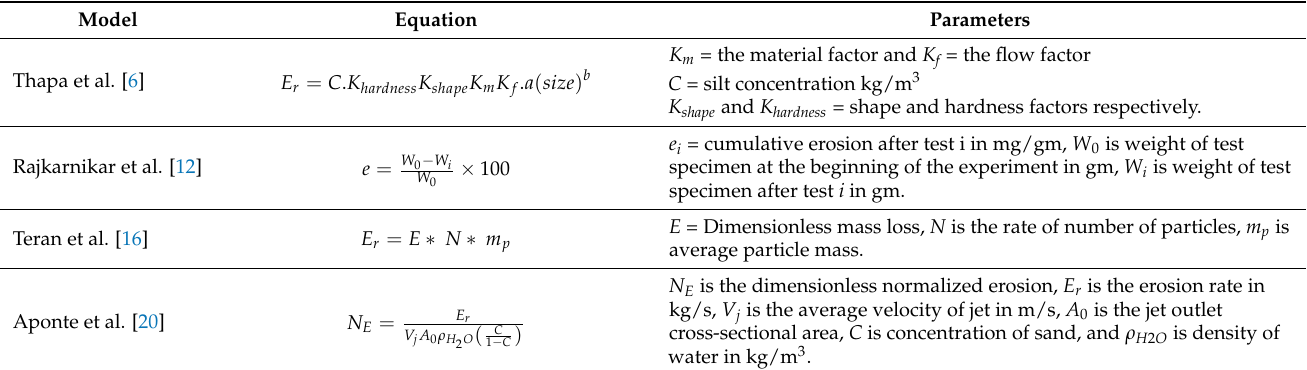
Table 1. Erosion models list for hydroelectric power turbines developed by various researchers. Model Equation Parameters Thapa et al. [6]